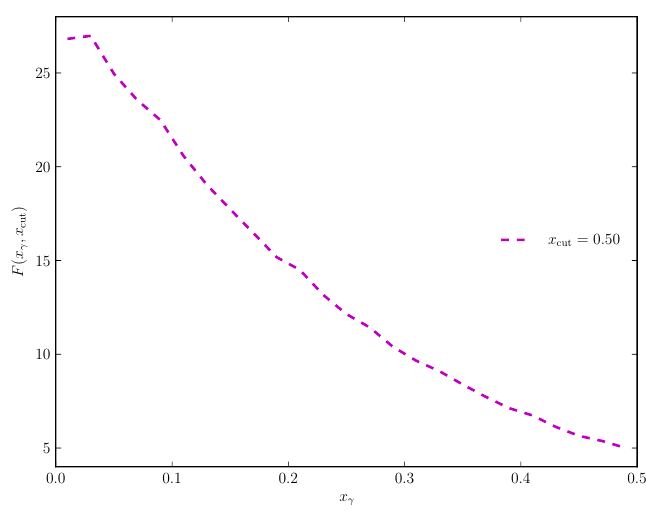
Figure 4 . The loop factor F ( x (cid:13) ; x cut ) as a function of x (cid:13) (cid:17) (cid:13)= (2 T ), where x cut is (cid:12)xed at 1 = 2, corresponding to the energy transfer from the vacuum to the plasma being smaller than T .